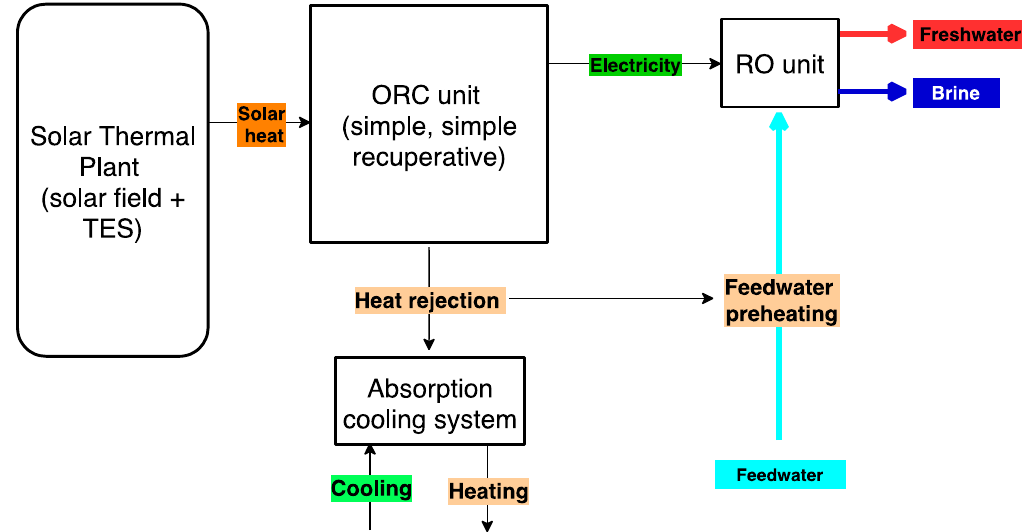
Figure 2. General scheme of a solar thermal-driven RO desalination and cooling system.